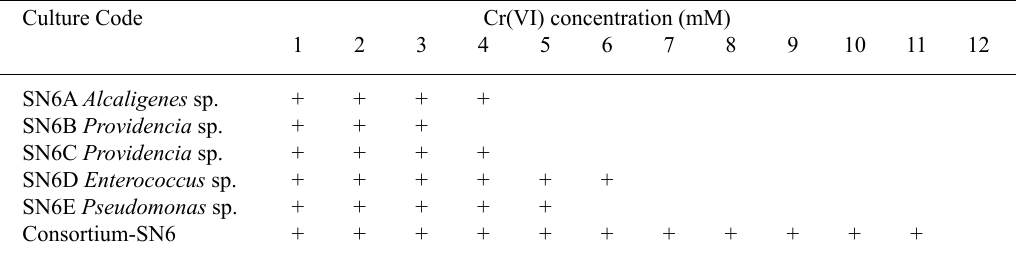
Table 2. Chromate resistance of consortium-SN6 and bacteria comprising it